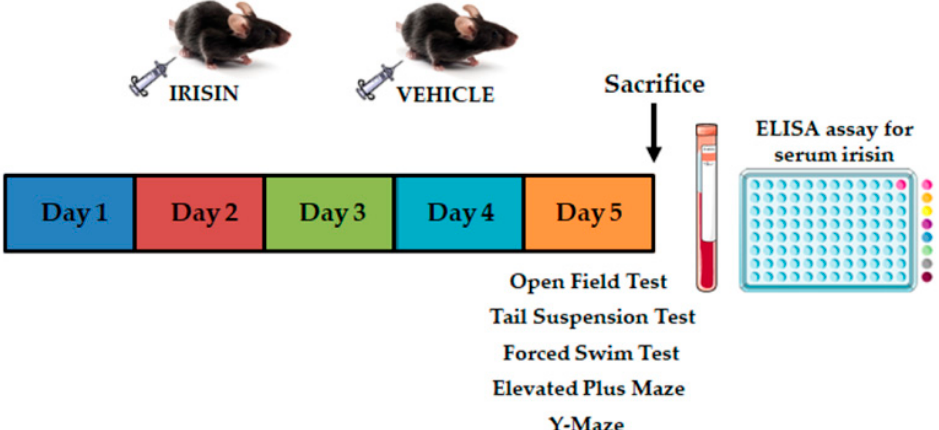
Figure 8. Experimental timetable. Time schedule of experimental design showed the behavioral tests performed after once-daily short-term protocol (5-day treatment), two hours after the fifth irisin or vehicle injection. ELISA assay for serum irisin was executed after mouse